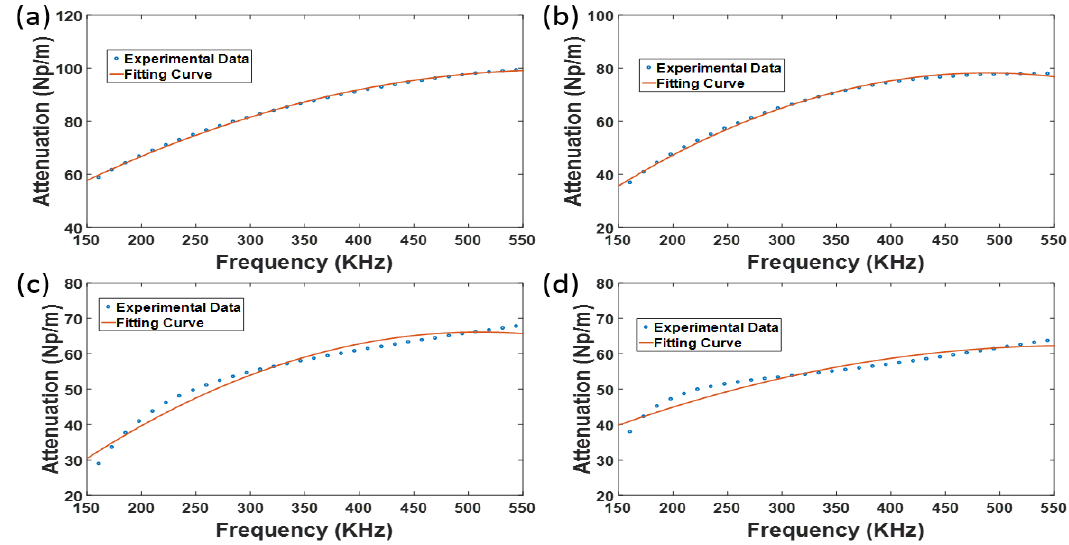
Figure 4. The curve fitting of the early-age cement paste attenuation with frequency. ( a ) Curve fitting at Day 1; ( b ) Curve fitting at Day 3; ( c ) Curve fitting at Day 7; ( d ) Curve fitting at Day 14.